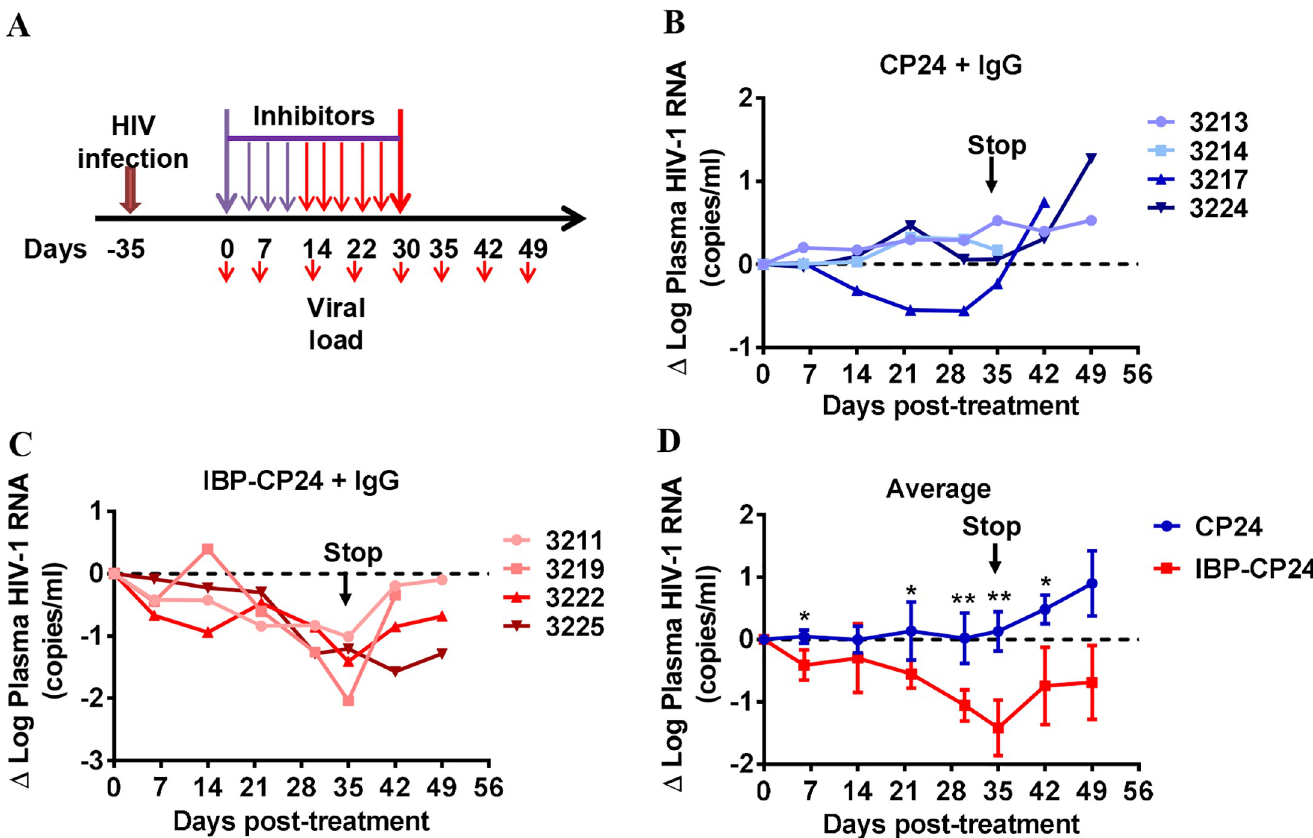
Fig 6. In vivo evaluation of the therapeutic efficacy of CP24 and IBP-CP24 in humanized mice with established HIV-1 infection. (A) Schematic diagram of the therapeutic experimental design. Humanized mice were infected with HIV-1 at day -35. At day 0, the infected mice received CP24 or IBP-CP24 treatment daily through day 14 (purple arrows). Beginning from day 14 to day 35, the mice received CP24 or IBP-CP24 treatment twice a day (red arrows). All mice were injected with human IgG twice every week. (B and C) The change of plasma viremia from baseline was monitored at the indicated time points in mice treated with CP24 (B) and IBP-CP24 (C). (D) Comparison of the changes of plasma HIV-1 RNA in humanized mice treated with CP24 or IBP-CP24. Each sample was tested in triplicate and data were presented as mean ± SD. (CP24 + IgG, n = 4; IBP-CP24 + IgG, n = 4). Unpaired, 2-tailed t test was performed. � P < 0.05, �� P < 0.01.